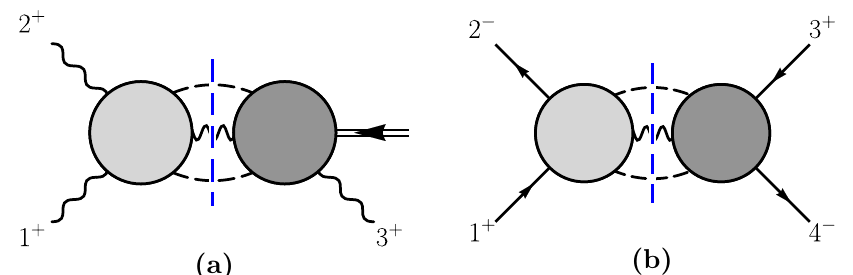
Figure 8 . (a) Unitary cut which determines the renormalization of O Note this form factor requires q 6 = 0, and the double-lined arrow indicates this insertion of additional o(cid:11)-shell momentum from the operator. (b) Unitarity cut which determines the renormalization of O and O by O or O . In each, the darker blobs indicate a higher-dimension ( 4 ) 1 ( 4 ) 2 ( ’ 2 F 2 ) 1 ( ’ 2 F 2 ) 2 operator insertion, and the dashed line indicates the integral over phase space of the particles crossing the